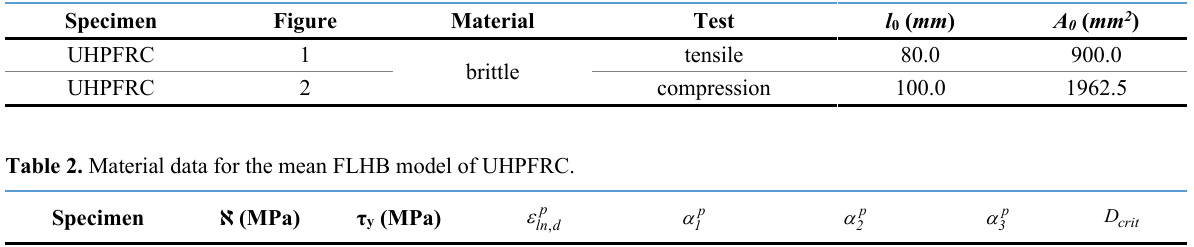
Table 1. Material and geometric data of specimens.